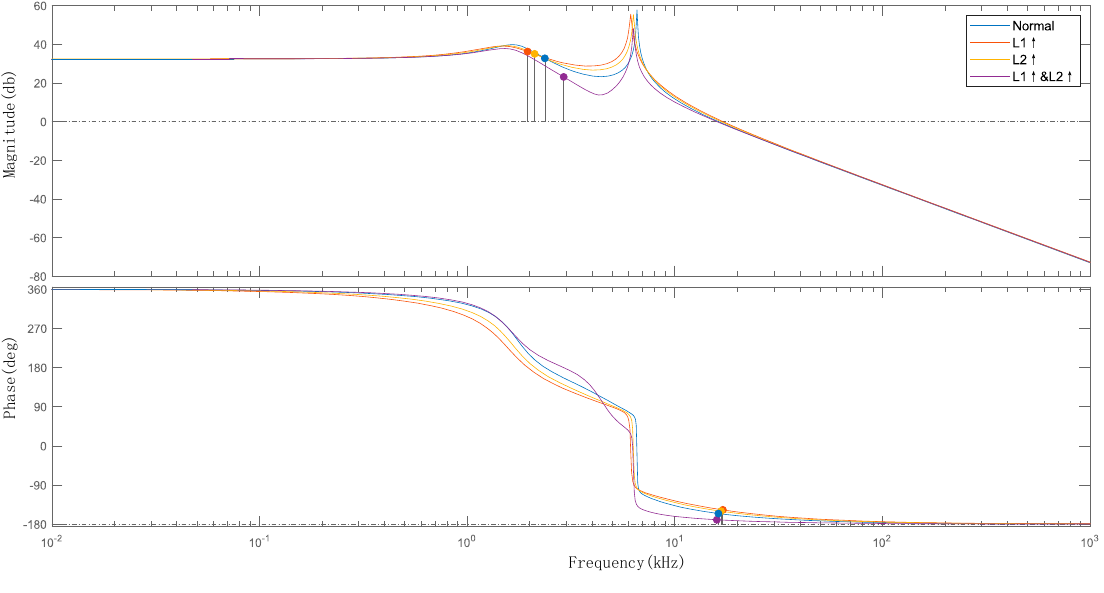
Figure 3. Bode diagram of Superbuck converter with recessive weakness. Table 2. System Stability